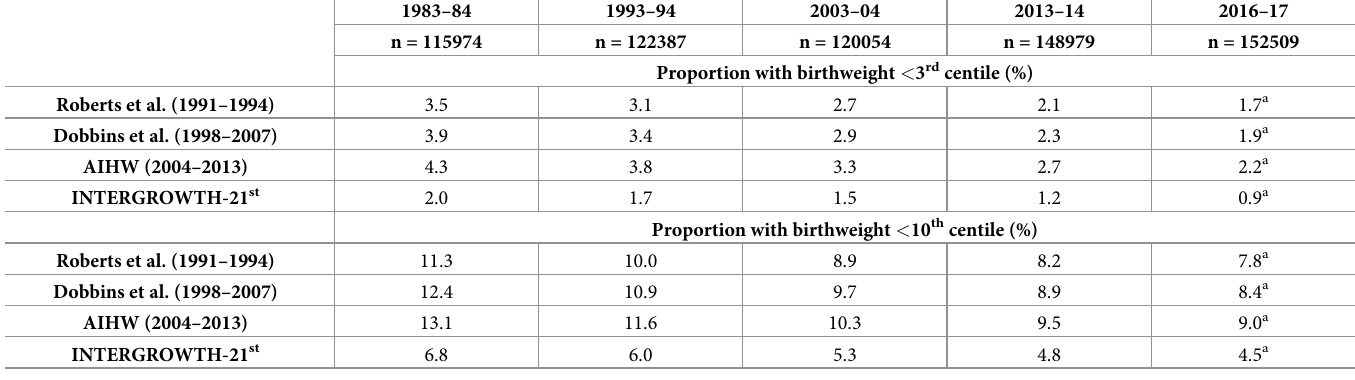
Table 3. Proportion (%) of babies born with birthweight < 3 rd and < 10 th centile between 34 and 42 weeks’ gestation in each two-year epoch by birthweight centile